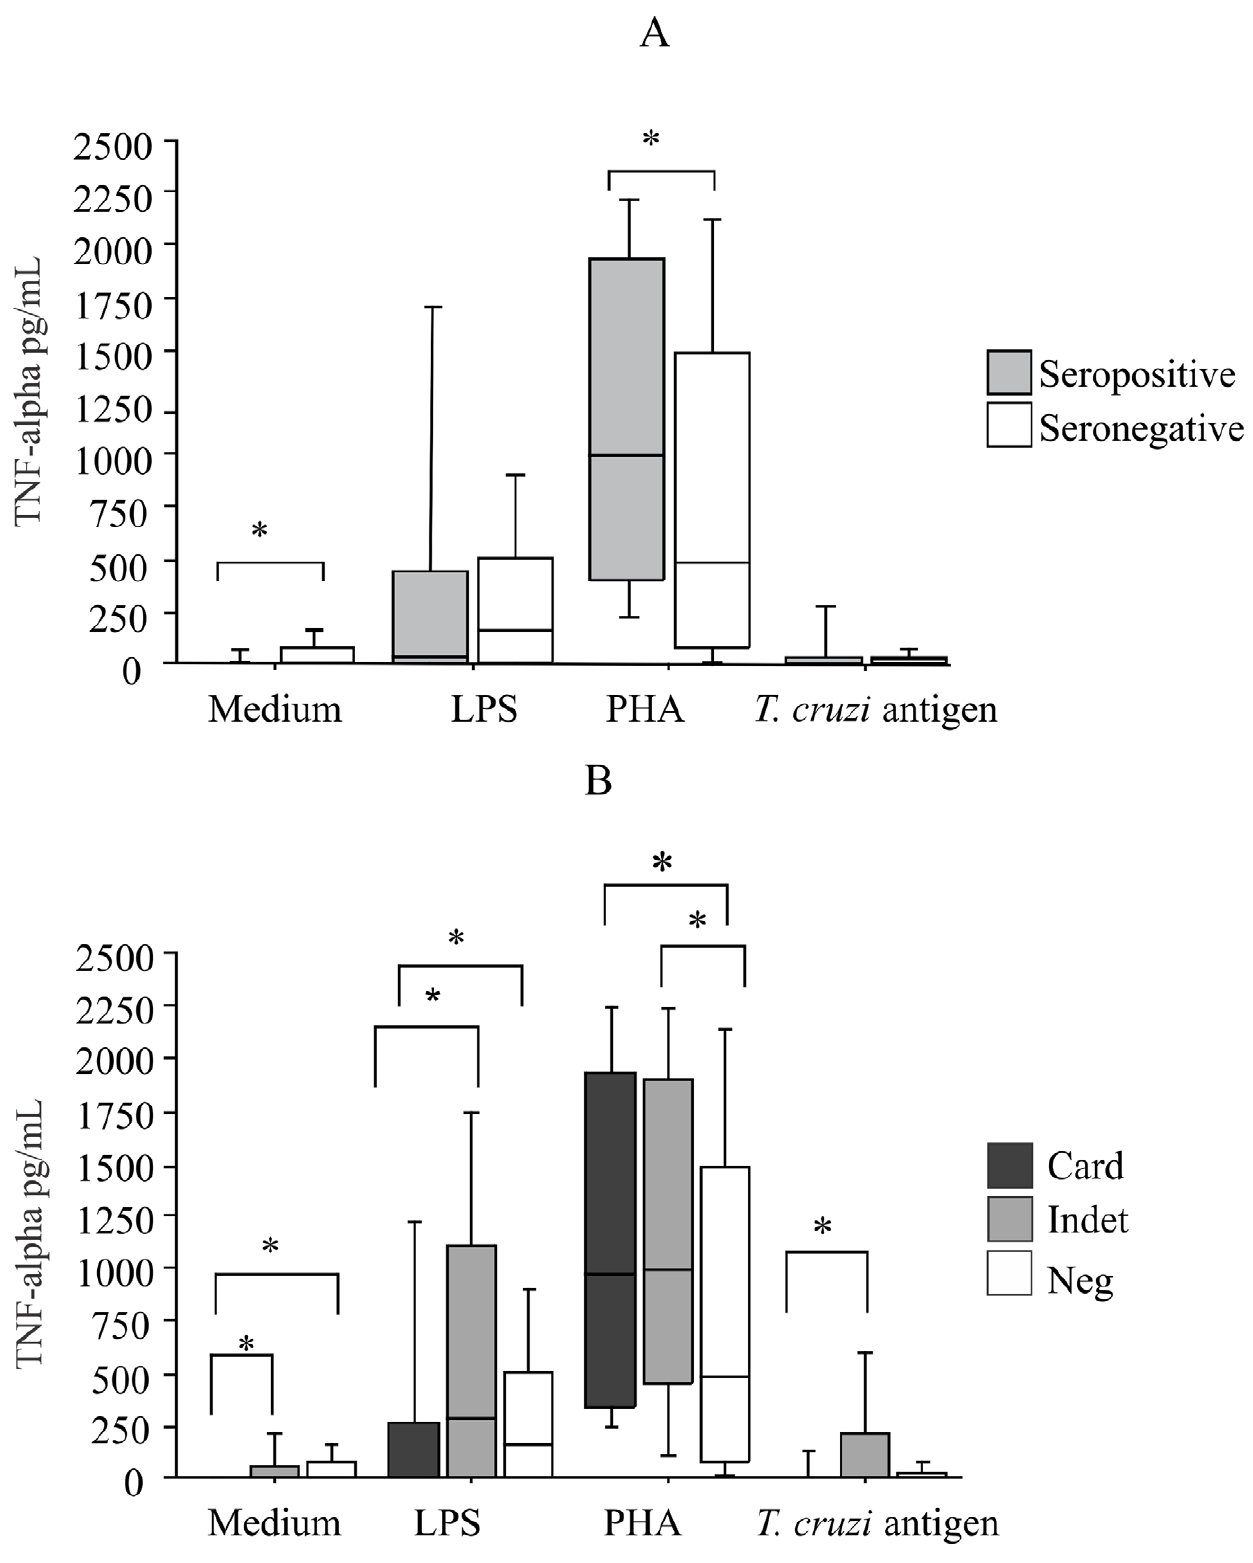
Figure 1. Levels of TNF-alpha in culture supernatants. TNF-alpha was assayed by ELISA in supernatants of PBMC cultured for 48 h in the absence of any stimulus and in the presence of T. cruzi antigen, LPS and PHA. A. Subjects were grouped according to positive or negative serology; *p=0.0003 (Mann-Whitney test). B. Subjects were grouped according to the cardiac or indeterminate form and negative serology: Cardiac x negative to medium: p=0.0002; cardiac x negative to LPS stimulation: p=0.005; indeterminate x negative to PHA: p=0.03; cardiac x indeterminate to medium: p=0.01; to LPS: p=0.005; to T. cruzi antigens: p=0.01 (Mann-Whitney test). Results are expressed as pg/mL. The horizontal line indicates the median, bars the 25% and 75% percentiles, and vertical lines the 10% and 90% percentiles.